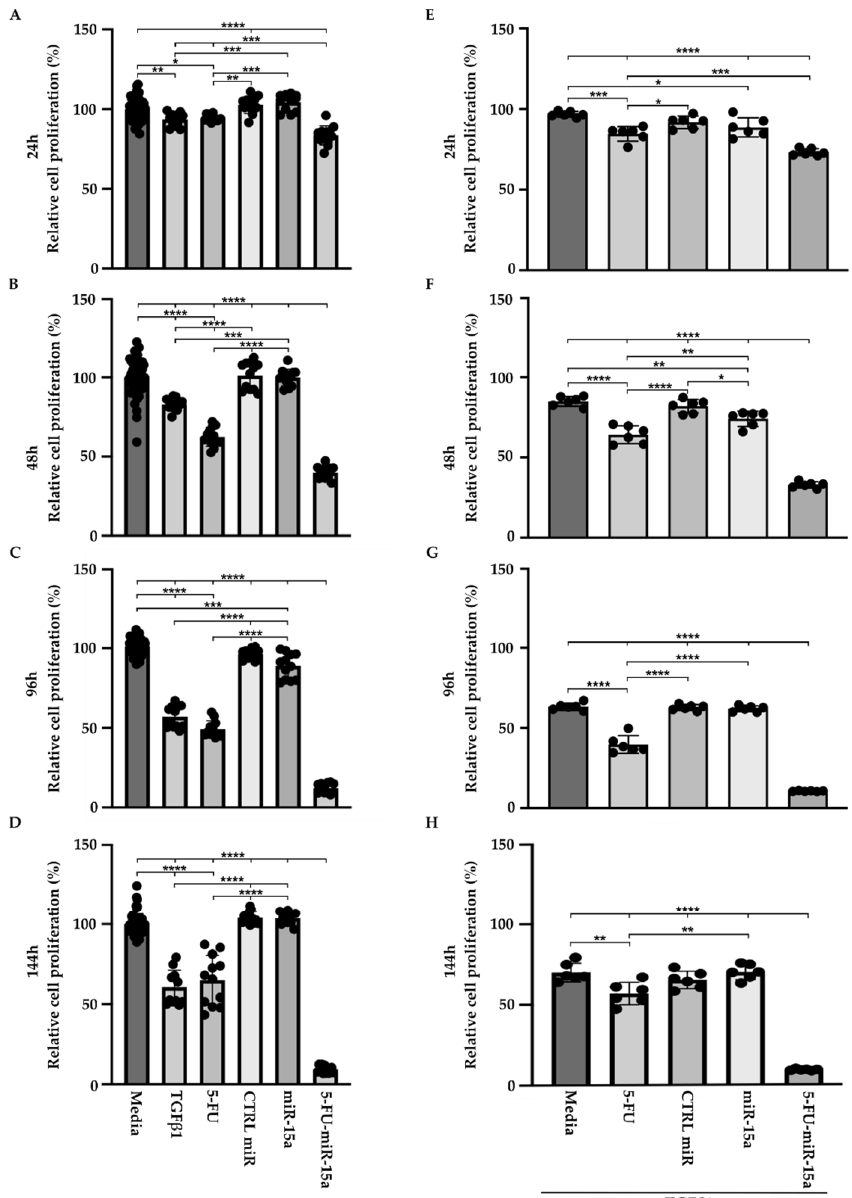
Figure 5. 5-FU-miR-15a inhibits the growth of murine pancreatic stellate cells as a single agent and in the context of TGF β 1 treatment. Pancreatic stellate cells were treated with TGF β 1, and/or 5-FU, CTRL miR, miR-15a, and 5-FU-miR-15a. Cell viability was assessed at ( A ) 24 h, ( B ) 48 h, ( C ) 96 h, ( D ) 144 h after single agent treatment, and at ( E ) 24 h, ( F ) 48 h, ( G ) 96 h, ( H ) 144 h after co-treatment with TGF β 1. Data are represented as the mean ± SD; N = 12 for a single treatment and N = 6 for a double treatment. * p < 0.05, ** p < 0.01, *** p < 0.001, and **** p < 0.0001 by One-Way ANOVA.